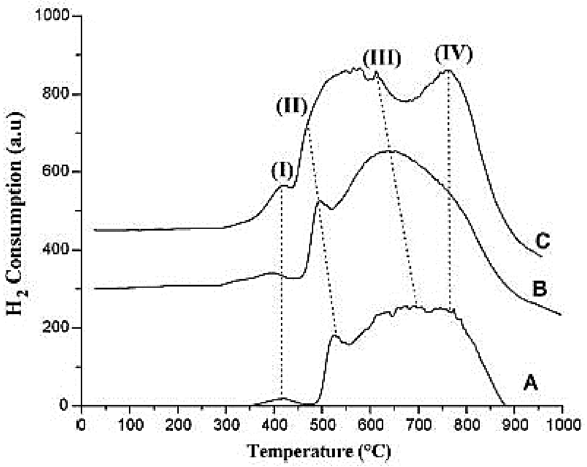
Fig. 5 TPR profile of Ni/Mg–O–Al catalyst with A : 15 wt%, B : 25 wt%, and C : 50 wt% of Ni loading